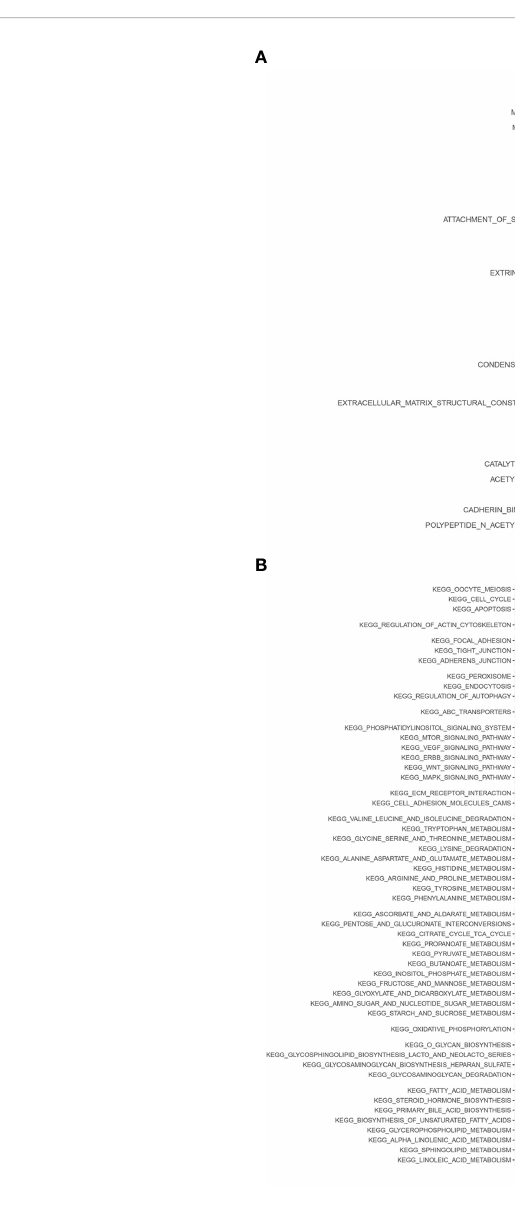
FIGURE 6 Functional and pathway enrichment analyses in a training cohort. (A) Gene Ontology (GO) analysis of differences between risk groups in three functional categories: Biological processes (BPs), cellular components (CCs), and molecular functions (MFs). (B) A Kyoto Encyclopedia of Genes and Genomes (KEGG) pathway enrichment analysis of differences between risk